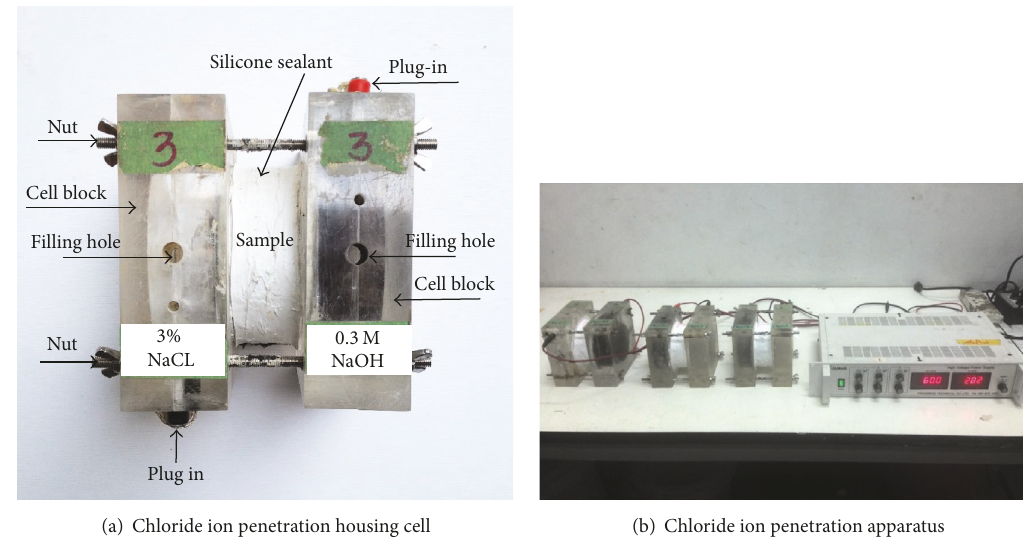
Figure 2: Installation test for the electrical indication of a concrete’s ability to resist chloride ion penetration.